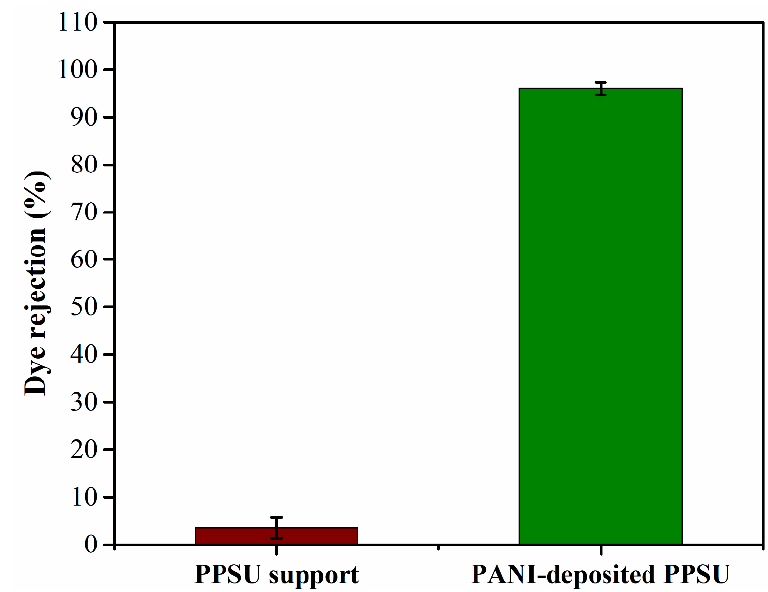
Figure 8. Rejection of the MB dye by the PPSU support membrane and the PANI-coated PPSU membrane.